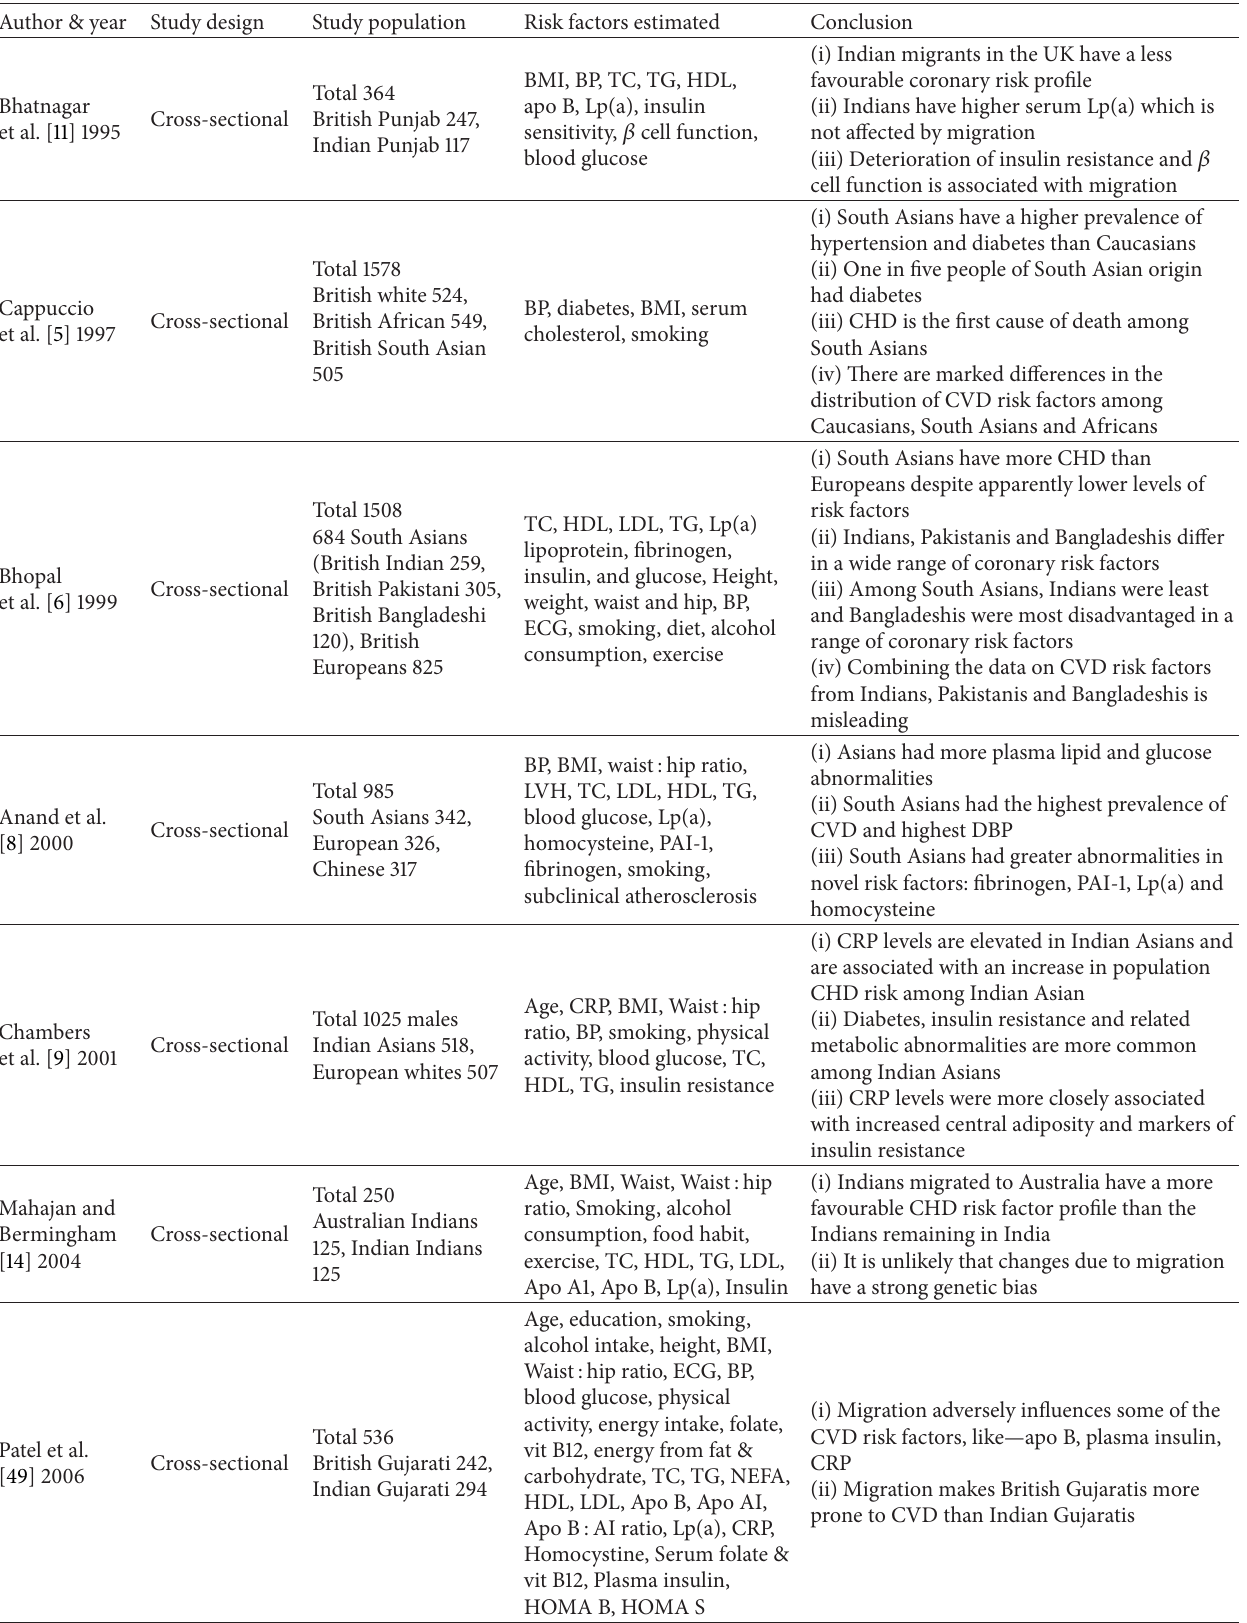
Table 1: Variations of risk factors in South Asians in their home countries or migrant South Asians compared with the other